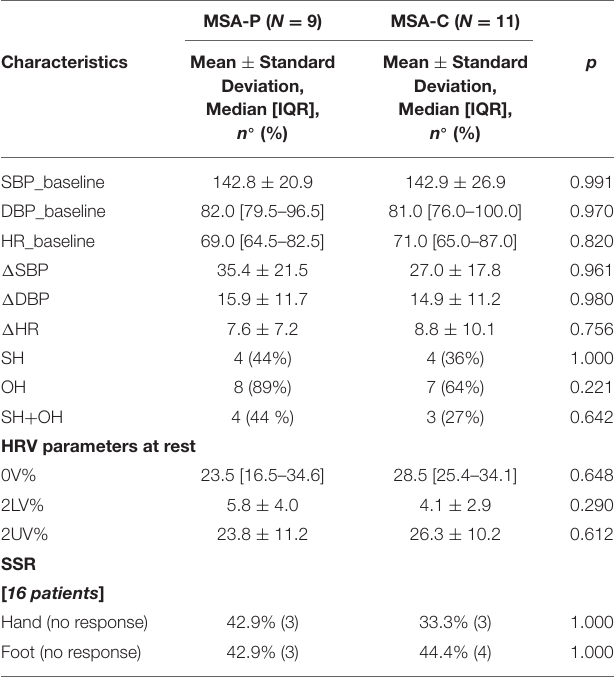
TABLE 2 | Cardiovascular and cutaneous dysautonomia evaluation in MSA-P and MSA-C patients.